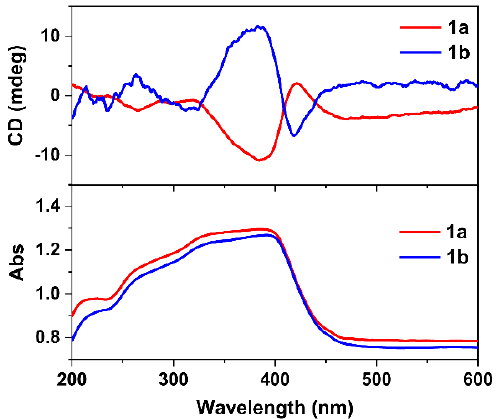
Figure 2. Solid-state CD spectra of 1a and 1b (KCl pellets).